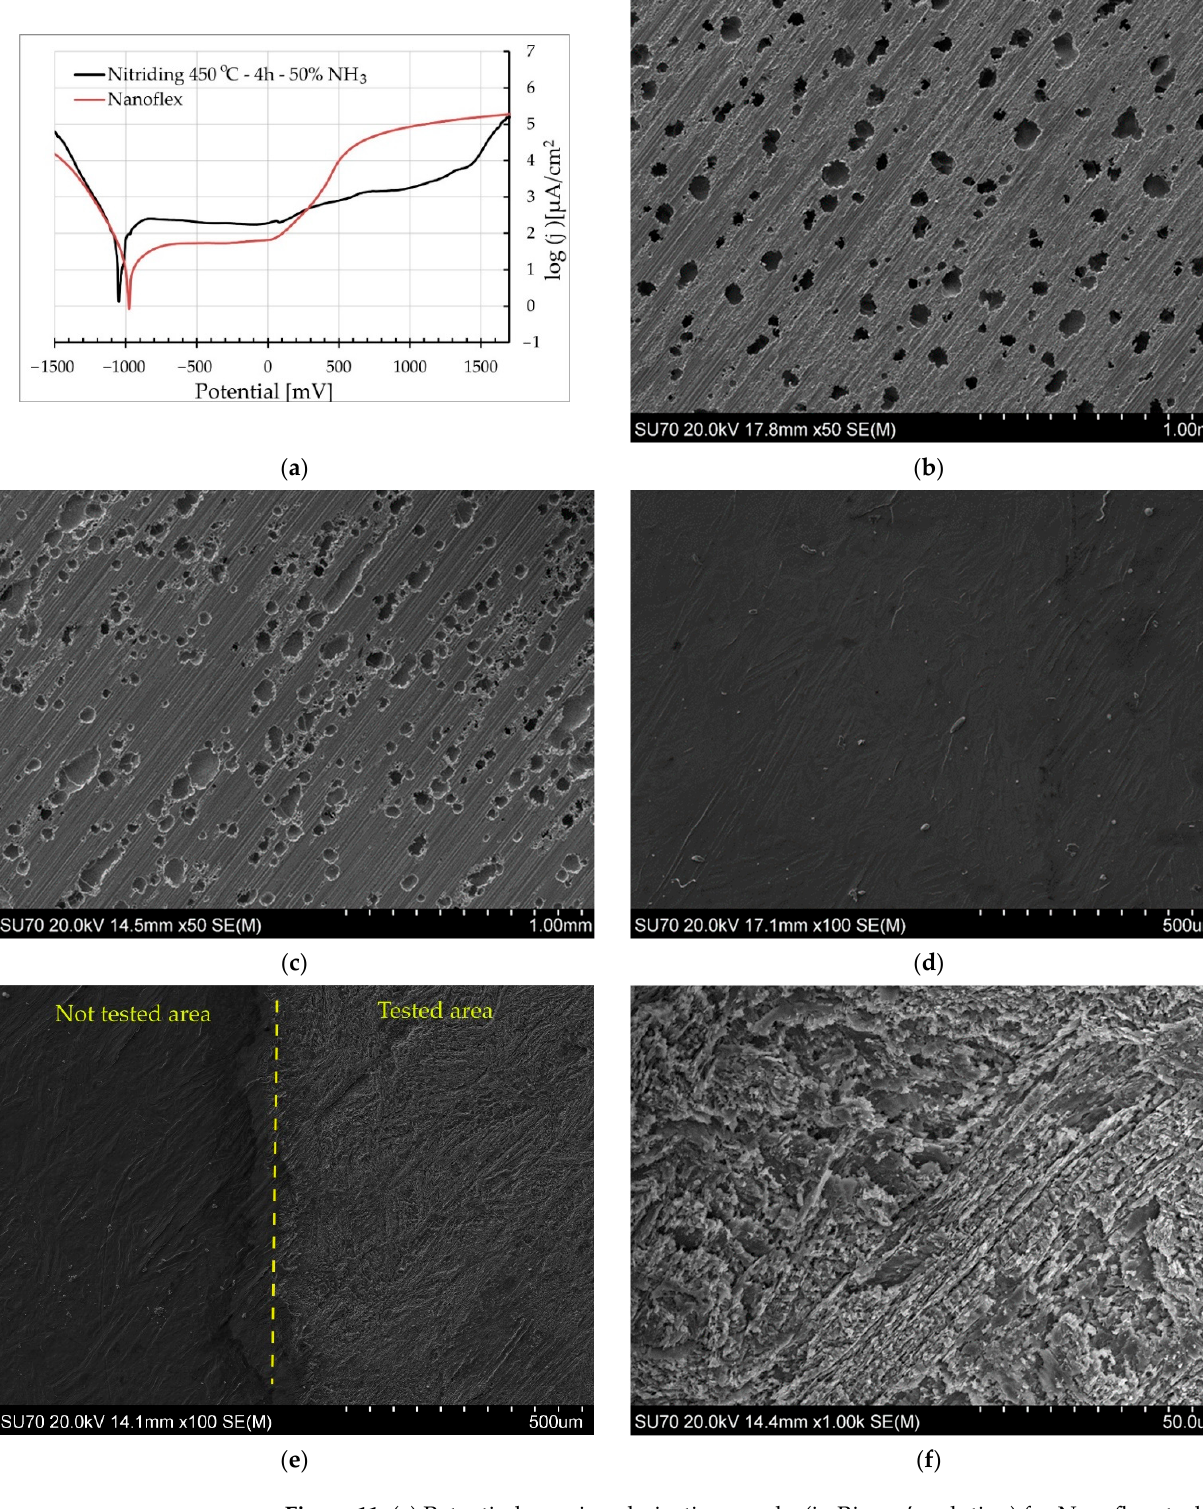
Figure 11. ( a ) Potentiodynamic polarization graphs (in Ringer’s solution) for Nanoflex steel under condition C and nitrided layer (450 °C, 4 h, 50% NH 3 ); ( b – f ) secondary electron images of surfaces after potentiodynamic corrosion tests of: ( b ) Nanoflex steel tested in 3% NaCl in water, ( c ) Nanoflex steel tested in Ringer’s solution, ( d ) nitrided layer (450 °C, 4 h, 50% NH 3 ) tested in Ringer’s solution, ( e , f ) nitrided layer (475 °C, 4 h, 100% NH 3 ) tested in Ringer’s solution.